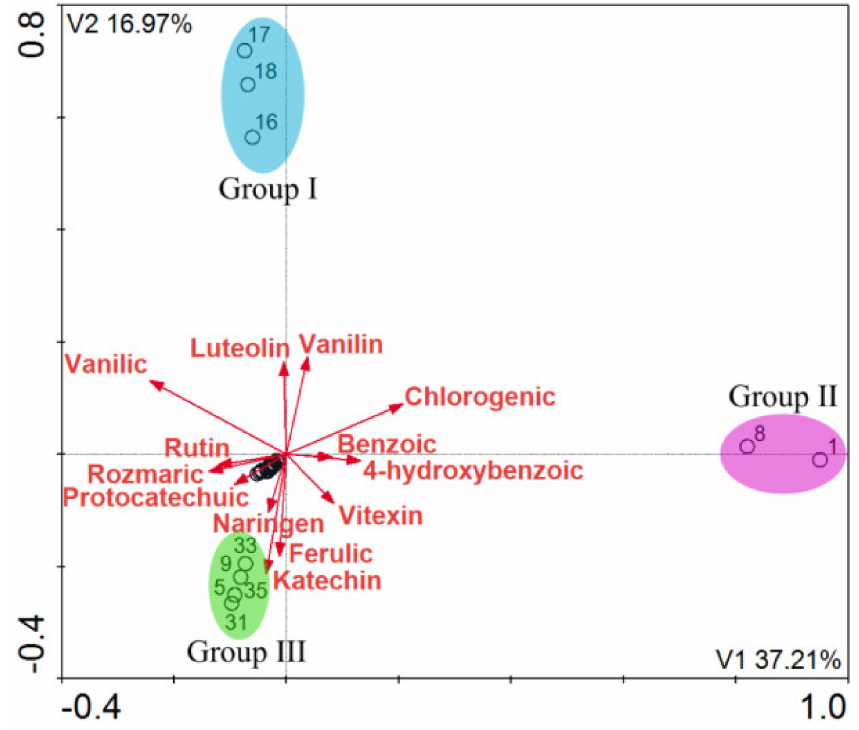
Figure 3. DCA ( n = 38) A diagram showing the distribution of the elderberry extract samples in terms of the content of polyphenols and flavonoids.